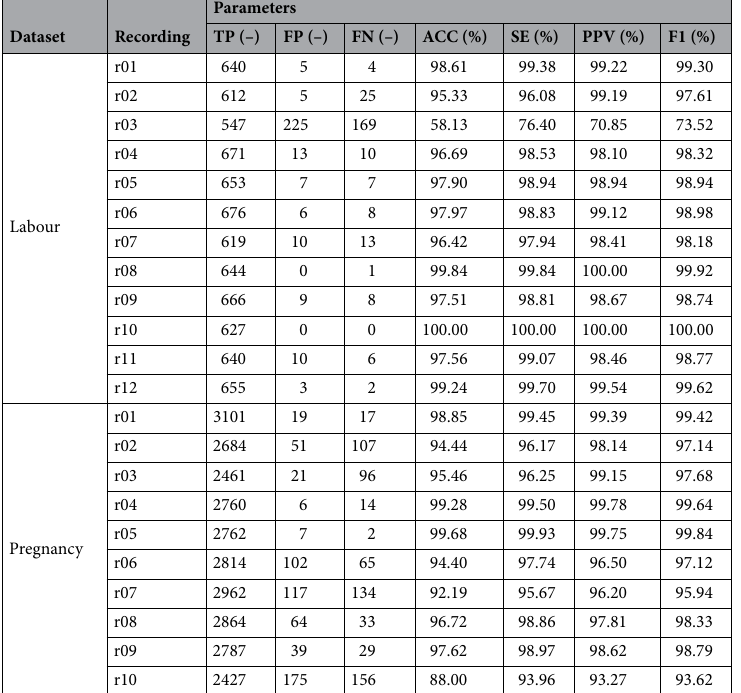
Table 2. Evaluation parameters of the R-peak detection accuracy obtained by SA-GWO algorithm tested on signals from labour dataset and the pregnancy